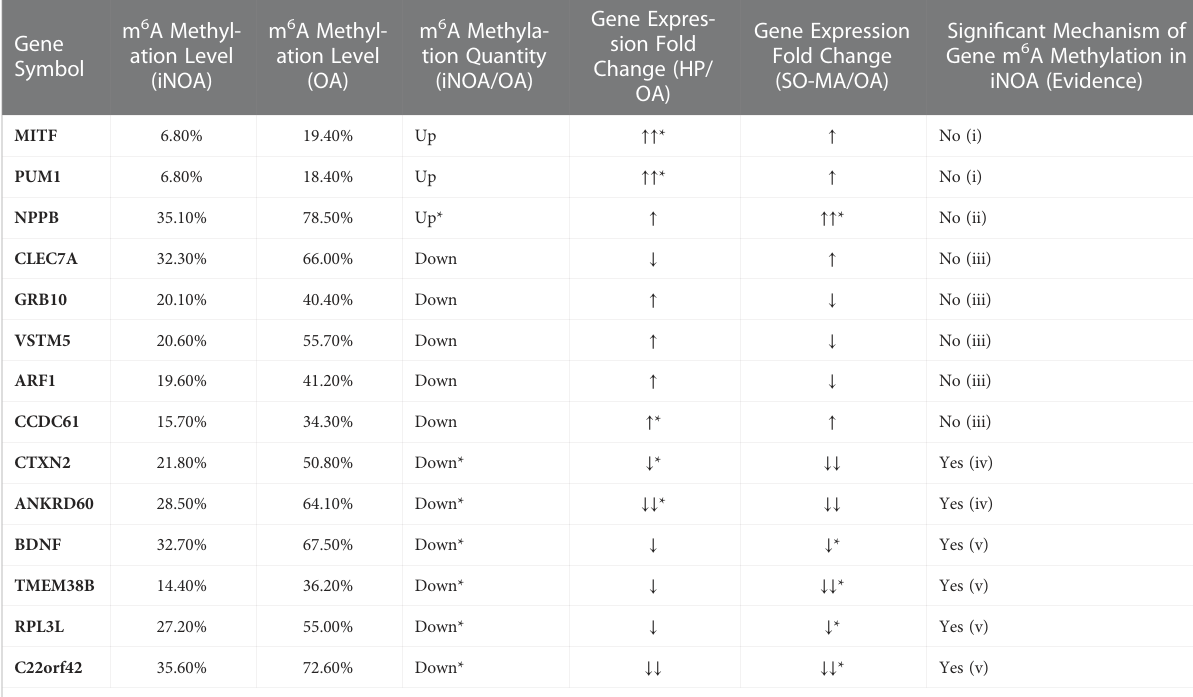
TABLE 3 To predict the importance of differentially expressed genes with signi fi cantly downregulated m 6 A Methylation levels in iNOA group using a 5-degree evidence evaluating system.